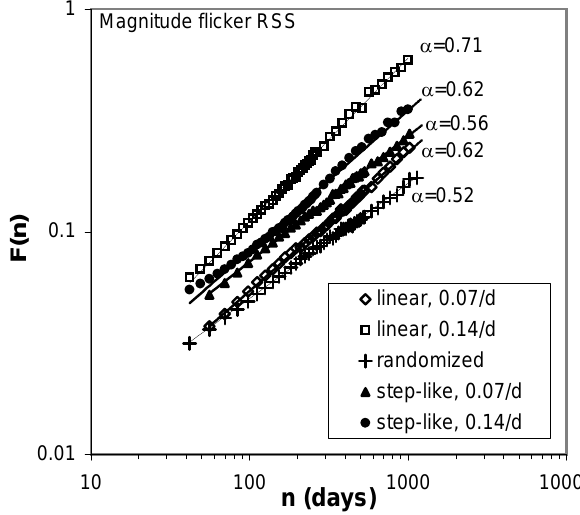
α exponent were step-like interpolated, resampled by the selected frequency (0.14 day -1 and 0.07